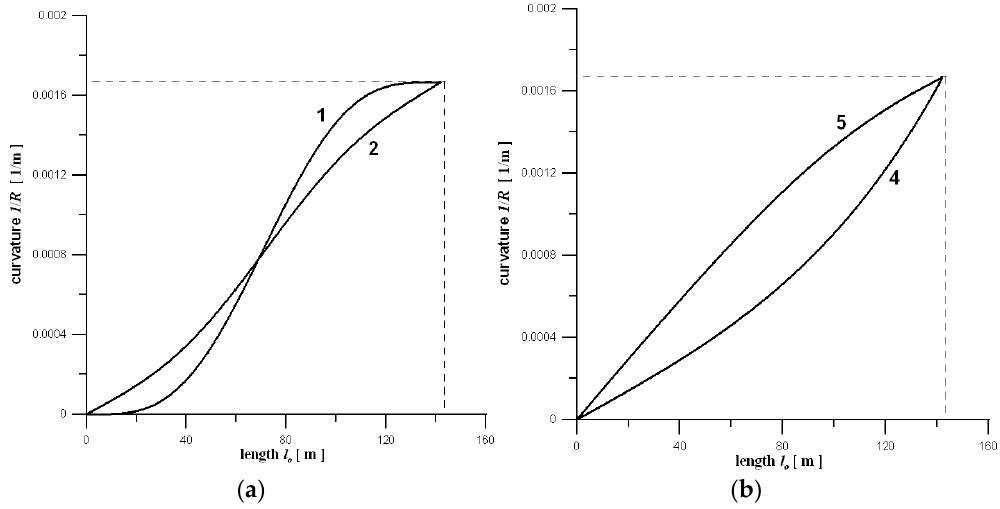
Figure 5. Types of curvatures: ( a ) 1 and 2; ( b ) 4 and 5. Table 2. The results of the optimization for 9th and 11th